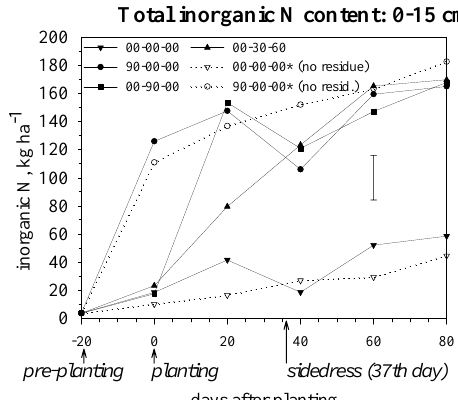
Figure 5. Soil total inorganic N content in the 0– 15 cm layer from 20 days before until 80 days after maize planting, as affected by the timing N application. 00–00–00: control; 90–00–00: 90 kg ha -1 of N at pre-planting; 00–90–00: 90 kg ha -1 of N at planting; 00–30–60: 30 kg ha -1 of N at planting plus 60 kg ha -1 of N at sidedressing. Vertical bars refer to the Tukey LSD ( P < 0.05) of each